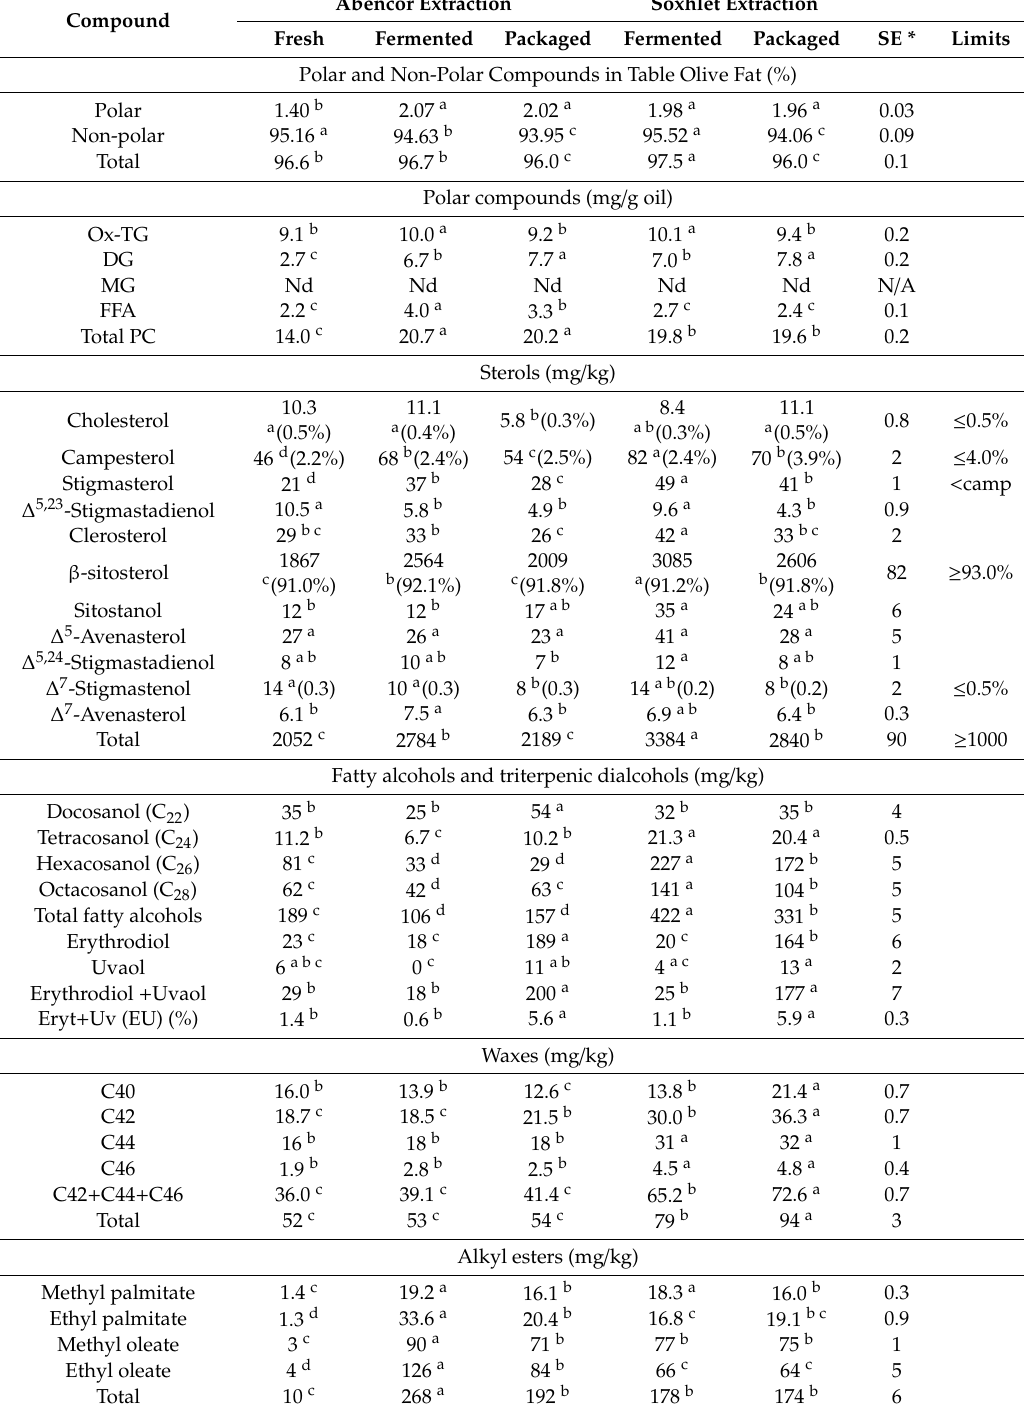
Table 1. Distribution of the green Spanish-style Gordal table olive fat between polar and nonpolar compounds as well as its concentration in minor components, according to processing phases and extraction